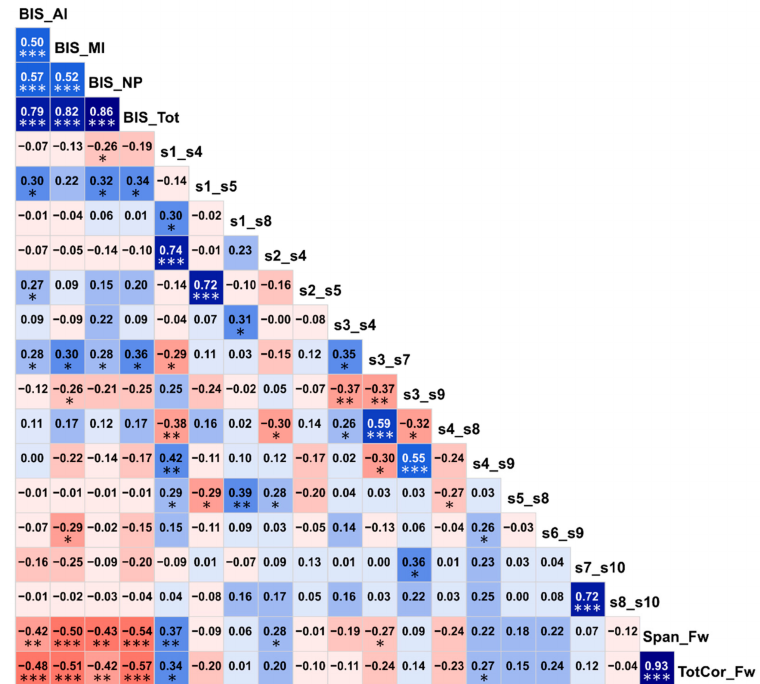
Figure 6. Correlation matrix showing associations among the top significant variables. The values within each cell represent the bivariate Pearson correlation between the variable on its vertical axis and the variable on its horizontal axis. The correlation values are color coded (red / pink shades represent negative r-values, blue / cyan shades indicate positive r-values, darker shades represent relatively higher magnitudes) and significant correlations have been marked with asterisks (* p < 0.05; ** p < 0.01; and *** p <